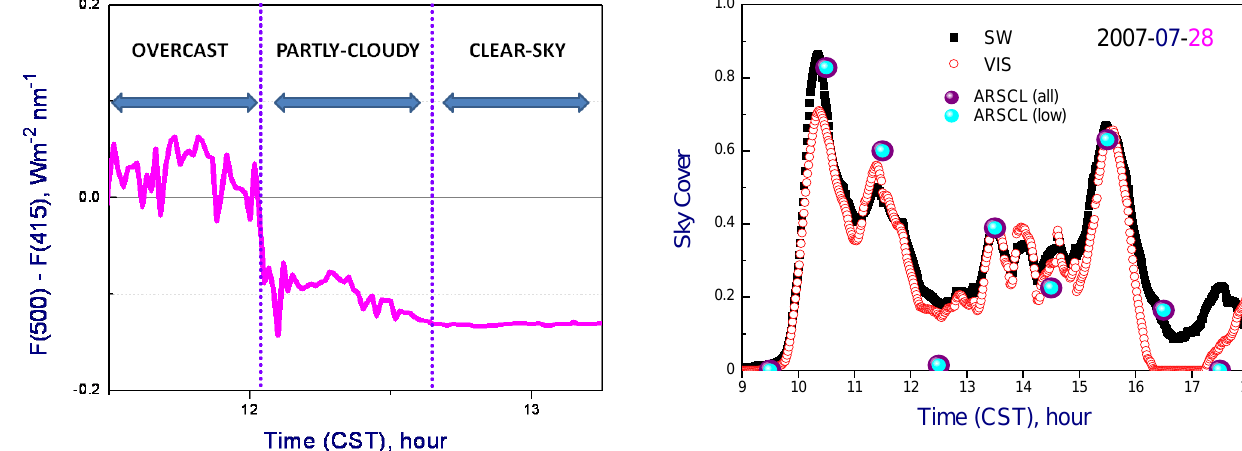
Fig. 4. Difference of diffuse fluxes at two wavelengths (415 and Fig. 4 . Difference of diffuse fluxes at two wavelengths (415 and 500 nm) as 500nm) as function of time for 16 July 2007. The completely over- cast cloudy (from 11:30 to 12:05CST) and clear-sky (from 12:65 to function of time for July 16, 2007. The completely overcast cloudy (from 11.5 13:25CST) are shown. The corresponding values of the fractional to 12.1 CST) and clear-sky (from 12.6 to 13.3 CST) periods occur during this sky cover are 0.0 and 1.0. The difference is positive and negative day. The corresponding values of the fractional sky cover are 0.0 and 1.0. The for the overcast and clear-sky periods, respectively. On the average, difference is positive and negative for the overcast and clear-sky periods, the absolute values of the clear-sky difference are almost three times respectively. On the average, the absolute values of the clear-sky difference larger than their overcast counterparts. are almost three times larger than their overcast counterparts.